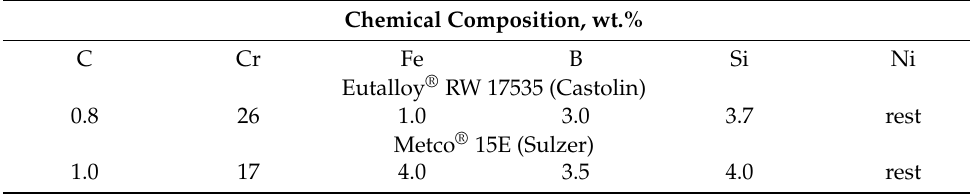
Table 2. Chemical composition of Ni-Cr-B-Si metal deposit according to the manufacturer’s data. Chemical Composition,